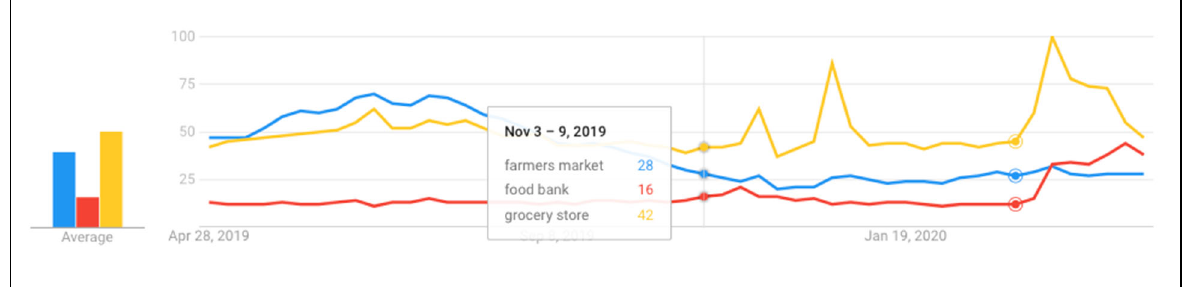
Figure 4. The Broader Context: Farmers Markets, Grocery Stores, and Food Banks